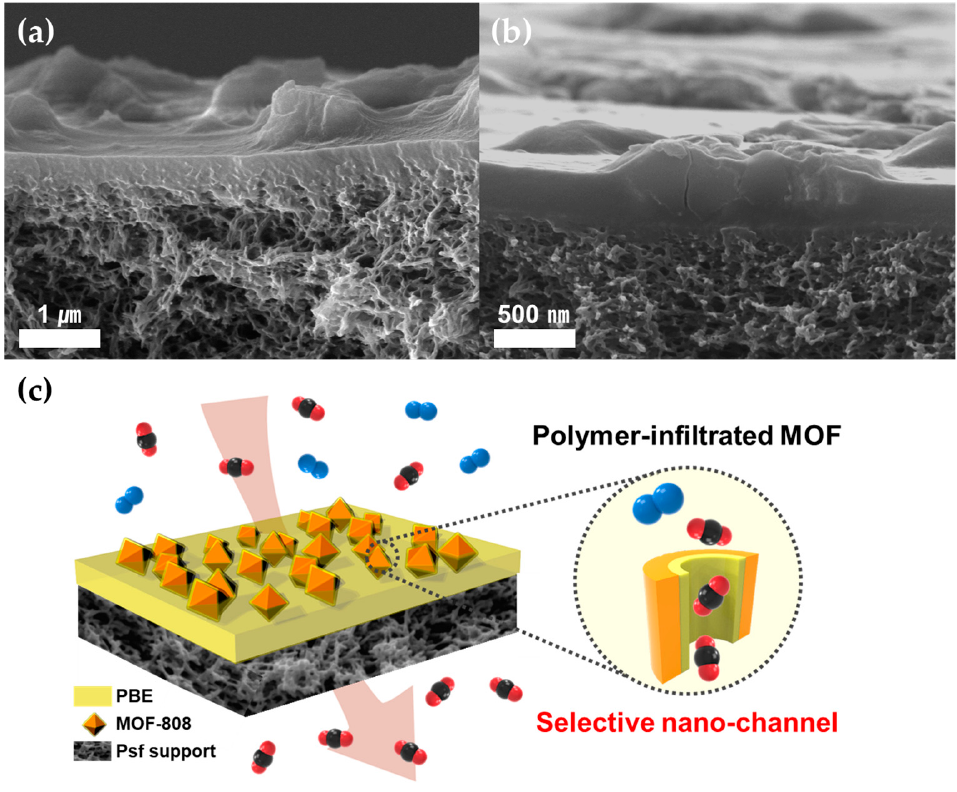
Figure 4. ( a , b ) Cross-sectional SEM images of PBE/MOF-808 40% TFC-MMM. ( c ) Schematic of TFC-MMM based on PBE-infiltrated MOF-808.